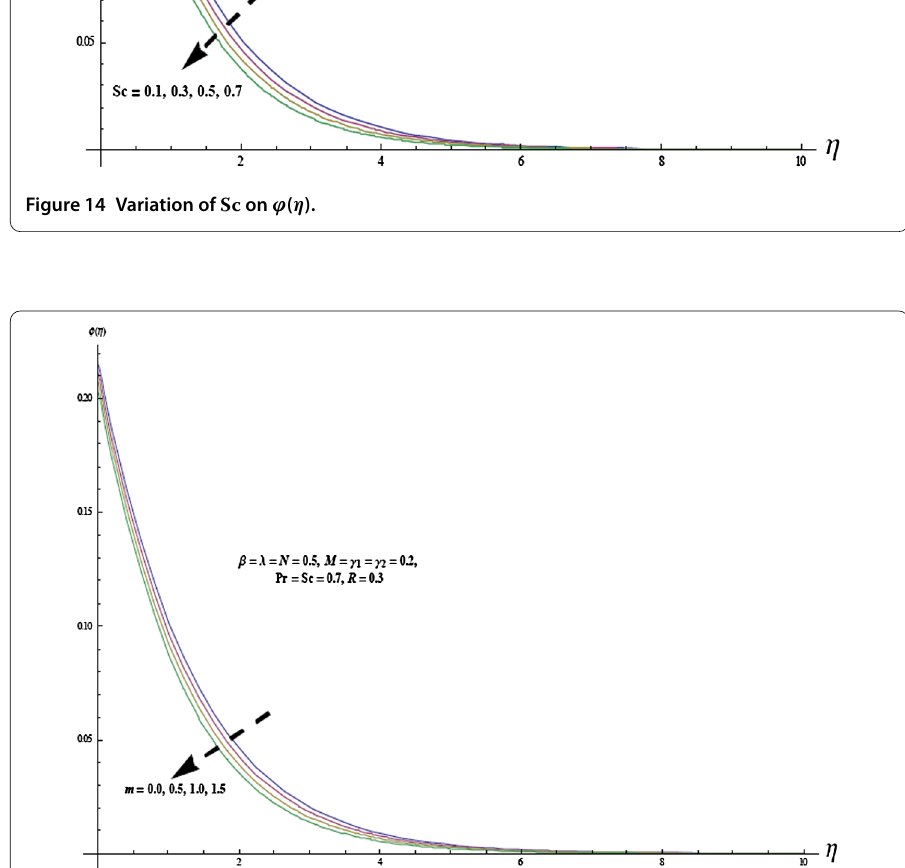
Figure 15 Variation of m on ϕ ( η